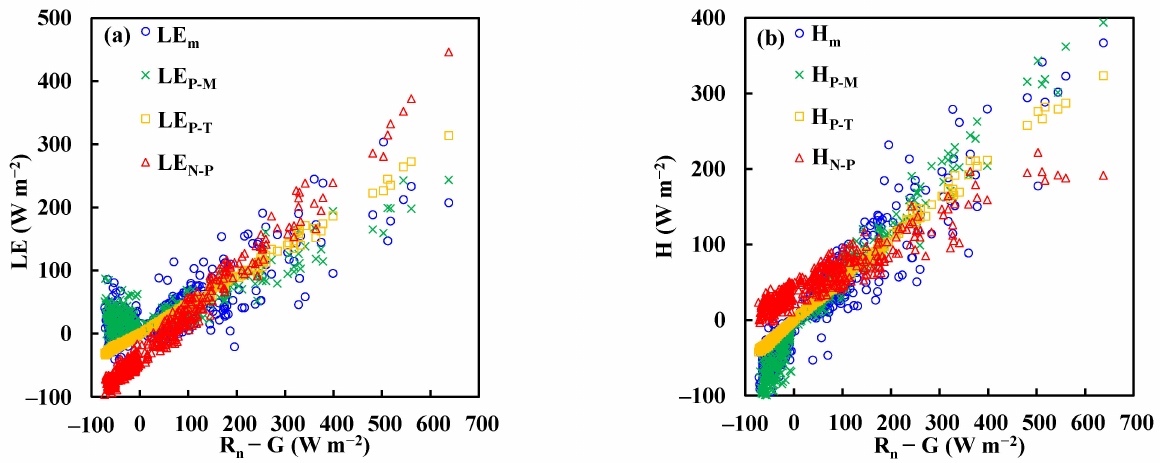
Figure 9. Scatter plots of measured and model-predicted LE ( a ) and H ( b ) as a function of available energy (R n − G) above the